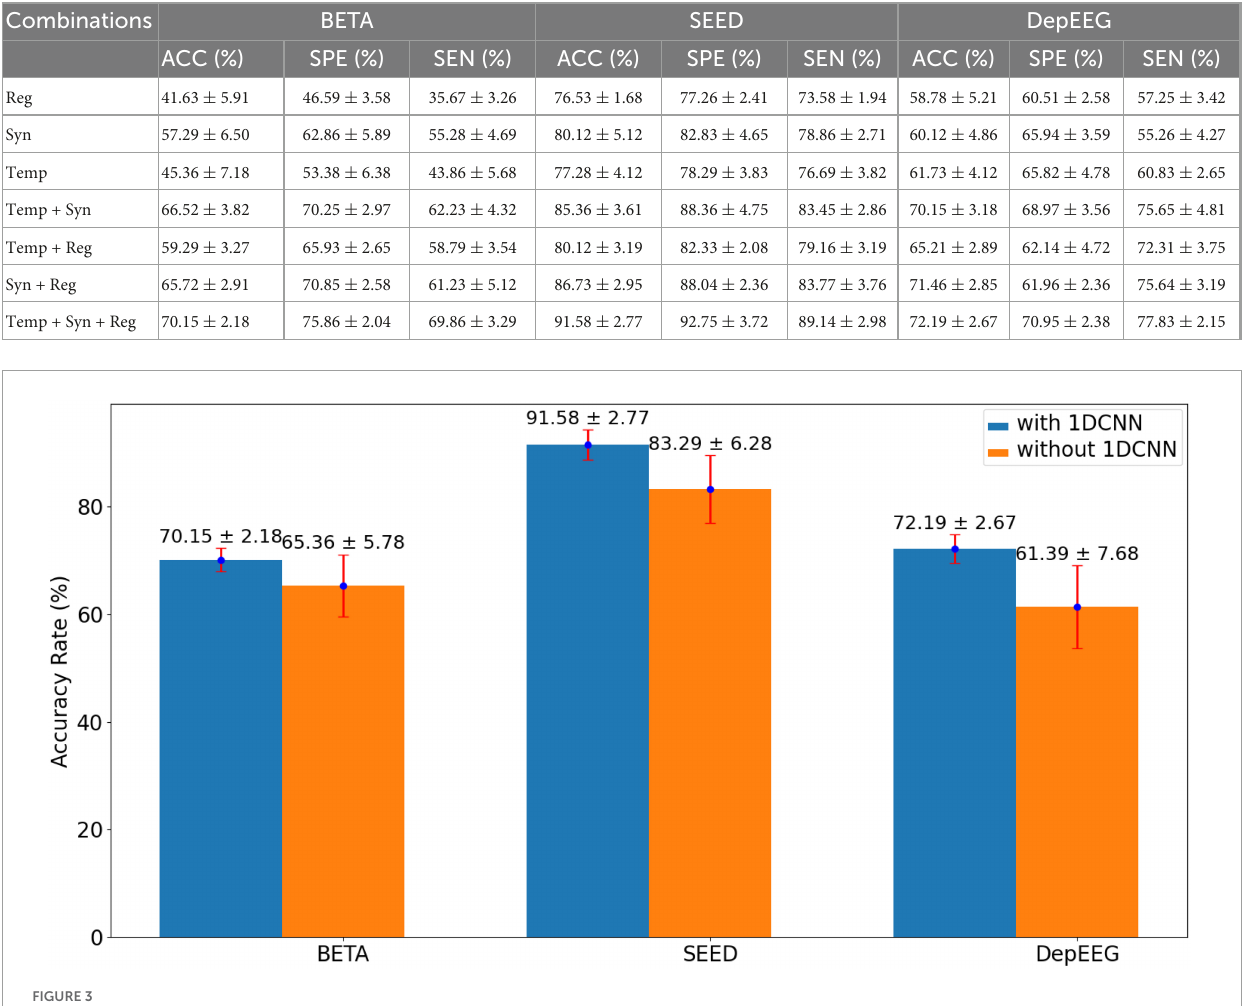
TABLE 2 Classification results (ACC, SPE, SEN, and their corresponding SDs) on the three EEG datasets by using different transformer module combinations to construct EEGformer encoders. Combinations BETA SEED DepEEG